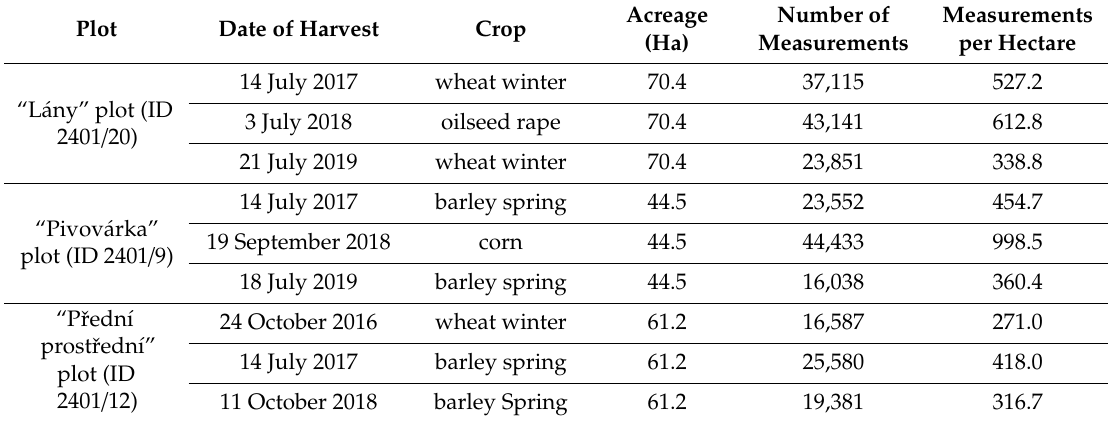
Acreage Number of Measurements (Ha) Measurements per Hectare